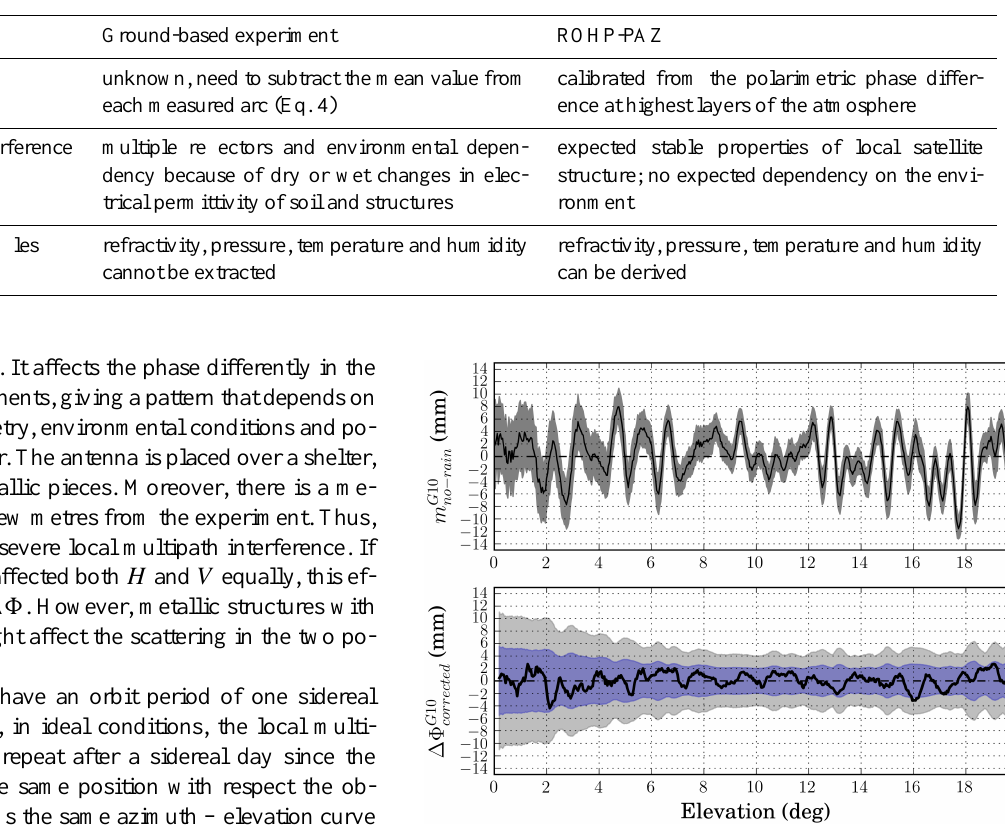
= (cid:49)(cid:56) PRN